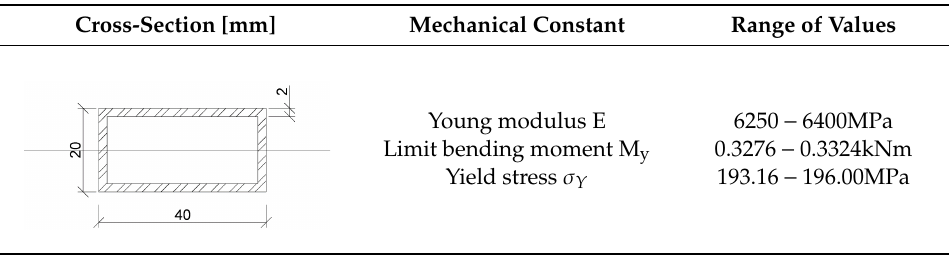
Table 1. Material parameters. Figure 4. Flow chart of the procedure .